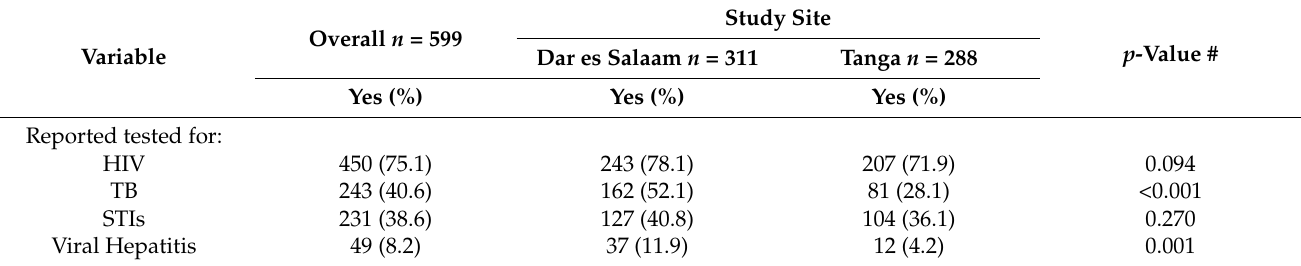
Table 2. Proportions of people who use drugs who reported ever being tested for drug-related infections and diseases, stratified by study site, Dar es Salaam and Tanga, in 2019, ( n = 599). Study Overall n = 599 Variable